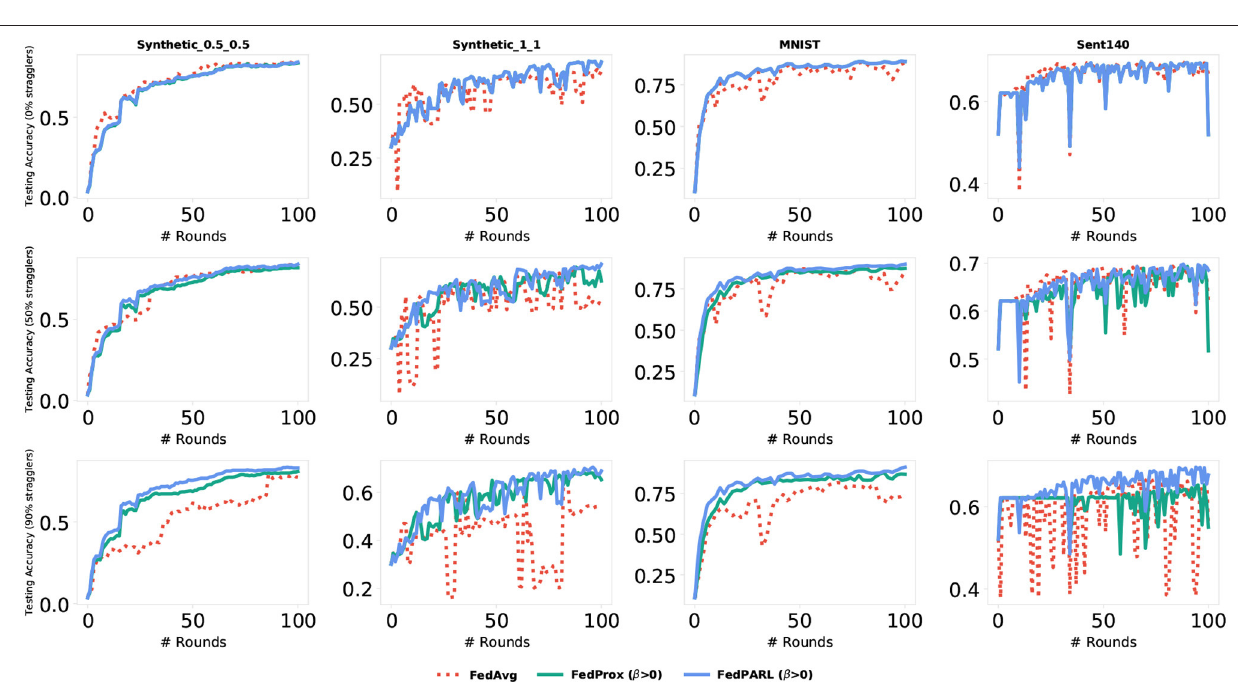
performs better than FedAvg and FedProx (see Figure 16 ). We also test our system with the federated dataset and obtained similar